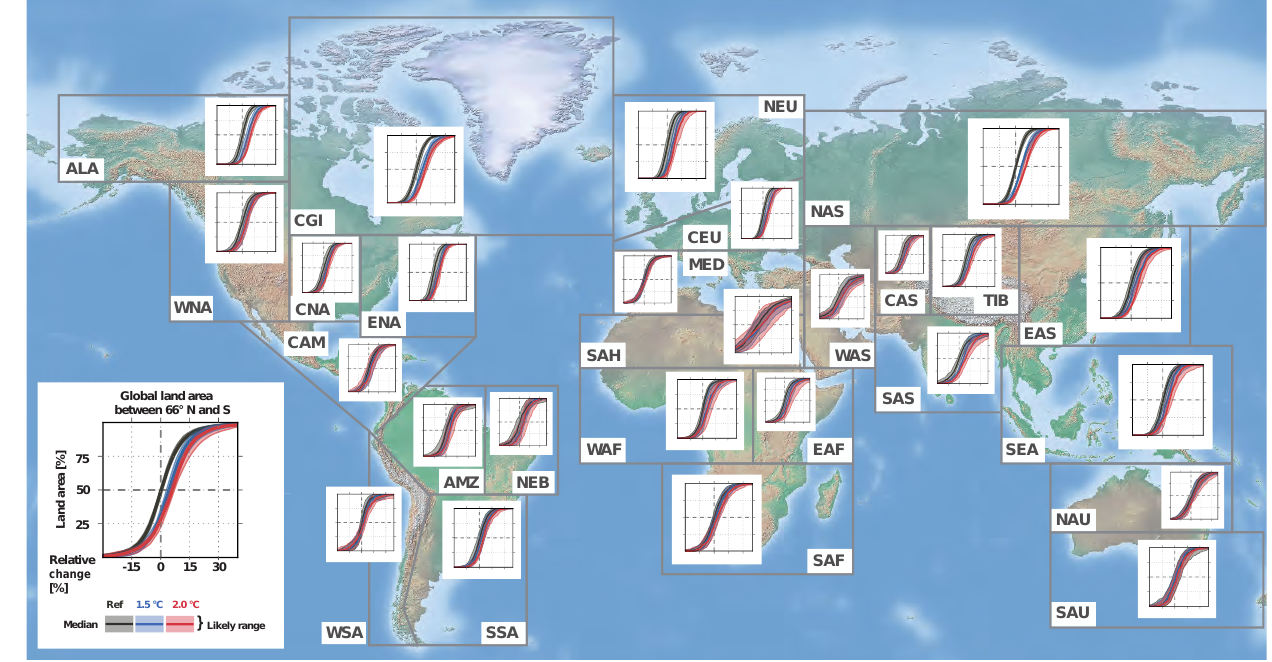
Figure 5. Same as Fig. 2 but for RX5day. Changes are given relative to the 1986–2005 reference period.